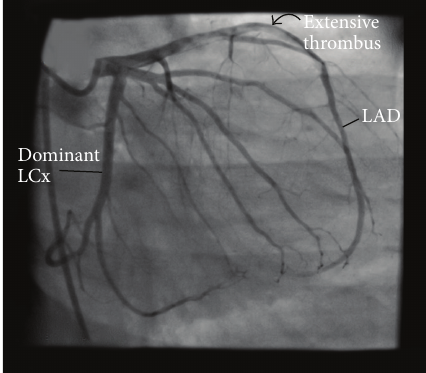
Figure 2: Preintervention angiographic image showing extensive LAD thrombosis. LAD: left anterior descending coronary artery; LCx: left circumflex coronary artery.